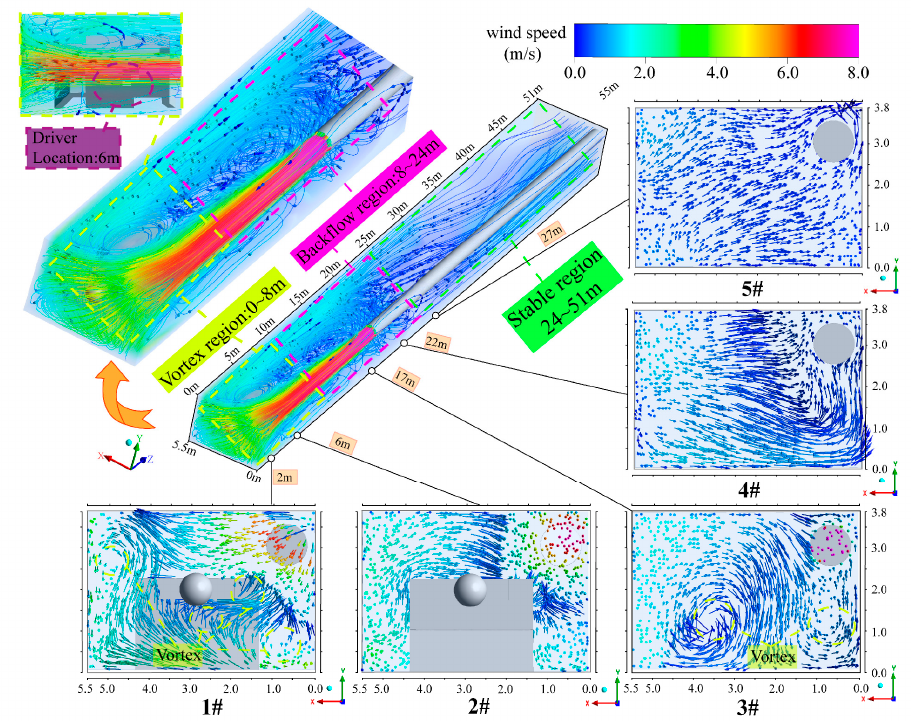
Figure 8. Analysis of airflow field and cross-sectional vector at the heaving face (dynamic tunneling model).